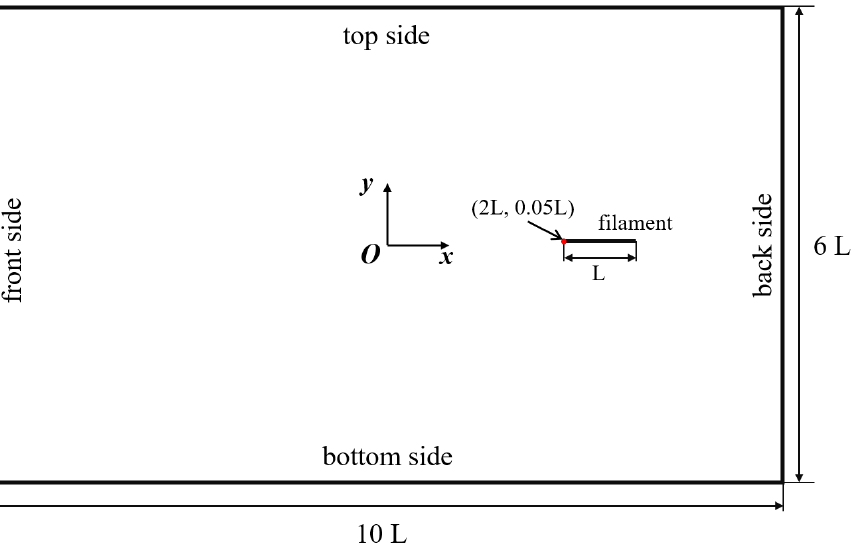
Figure 2. Computational domain and boundary conditions used in the